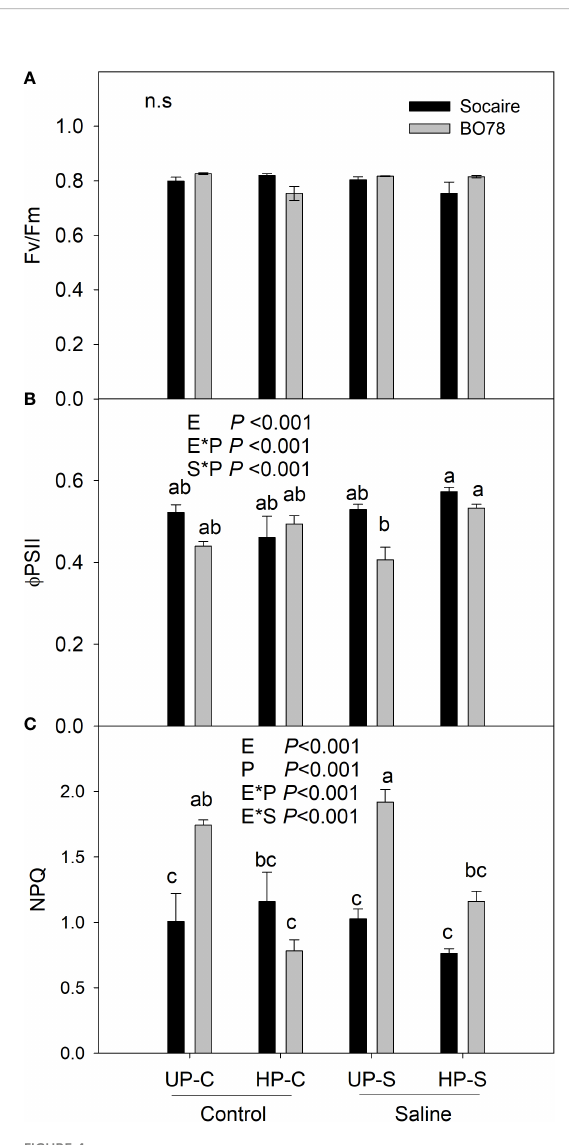
Salinity and priming effect on the chlorophyll a fl uorescence parameters of Socaire and BO78 ecotypes. Haloprimed and unprimed seeds of both ecotypes were germinated and grown under control and salinity conditions. At 20 days after germination, chlorophyll a fl uorescence parameters were registered: Fv/Fm, maximum ef fi ciency of the PSII (A) , FPSII, effective quantum yield (B) , and NPQ, non-photochemical quenching (C) . Error bars show mean ± SE (n = 6). Letters indicate signi fi cant differences between ecotypes (E, Socaire or BO78), priming (P, UP or HP), and treatment (C or S) using threeway ANOVA. Tukey HSD was used as a post-hoc test ( p <